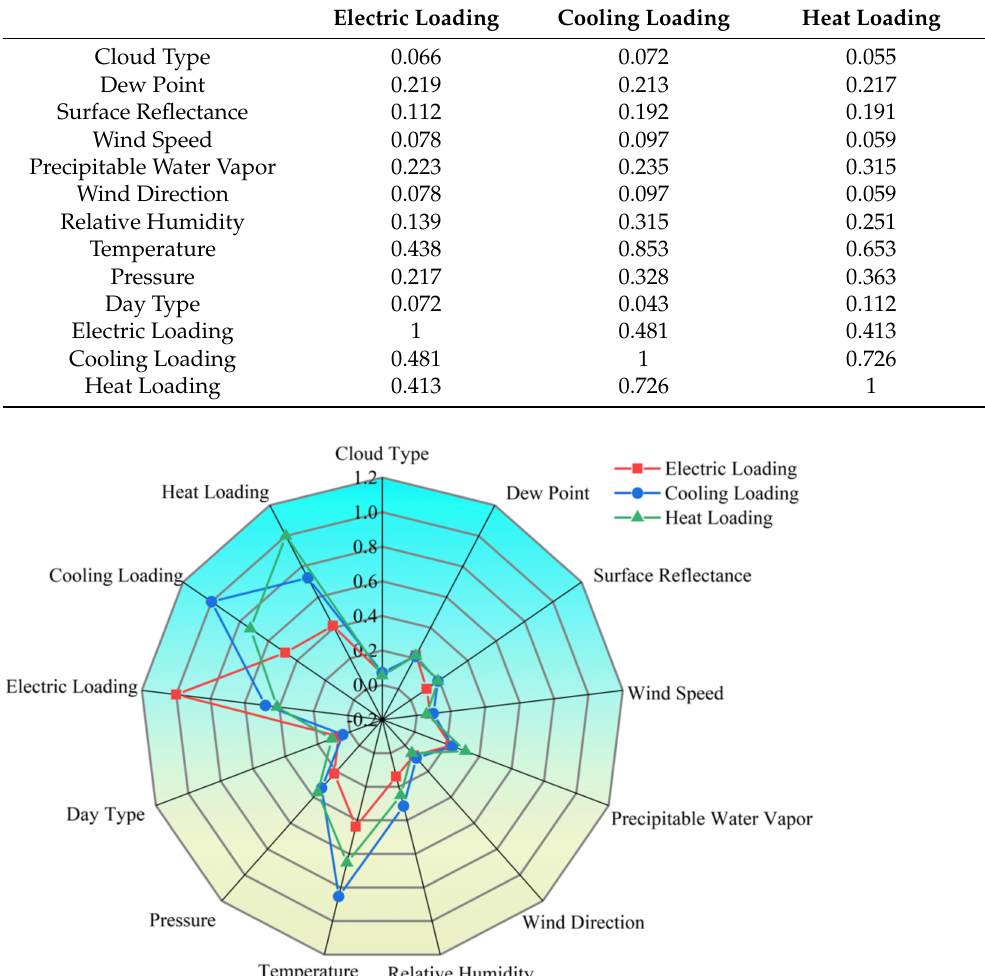
Figure 9. The correlation analysis results between electric, cooling and heat loads and characteristics.